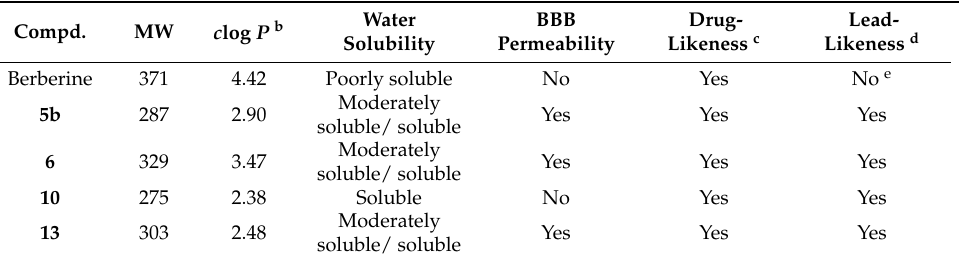
Table 3. Summary of calculated pharmacokinetic properties of berberine and the most strictly related compounds ( 5b , 6 , 10 , and 13 ) by SwissADME a . Compd.